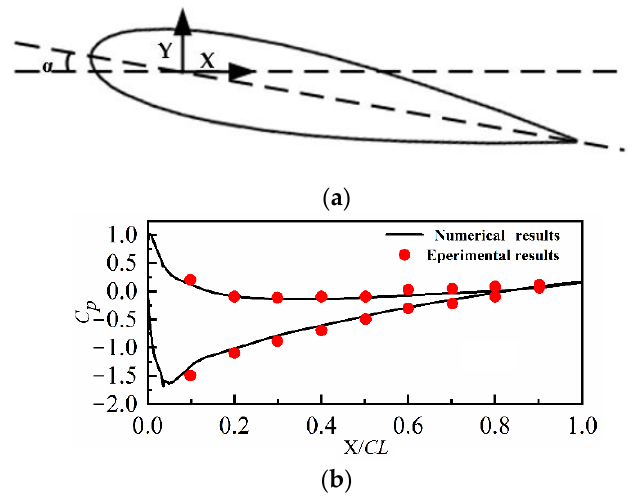
Figure 5. Comparison of the pressure distribution. ( a ) Experimental condition; ( b ) Time-averaged pressure coefficient.